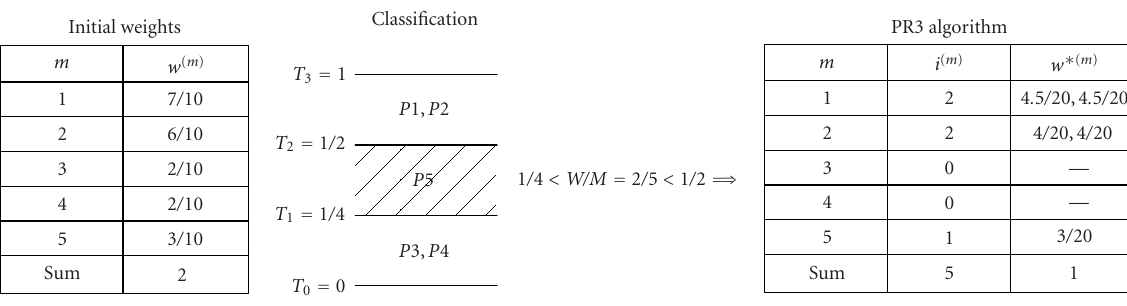
Figure 4: OPR method combined with the PR3 method used for final computation of weights and replication